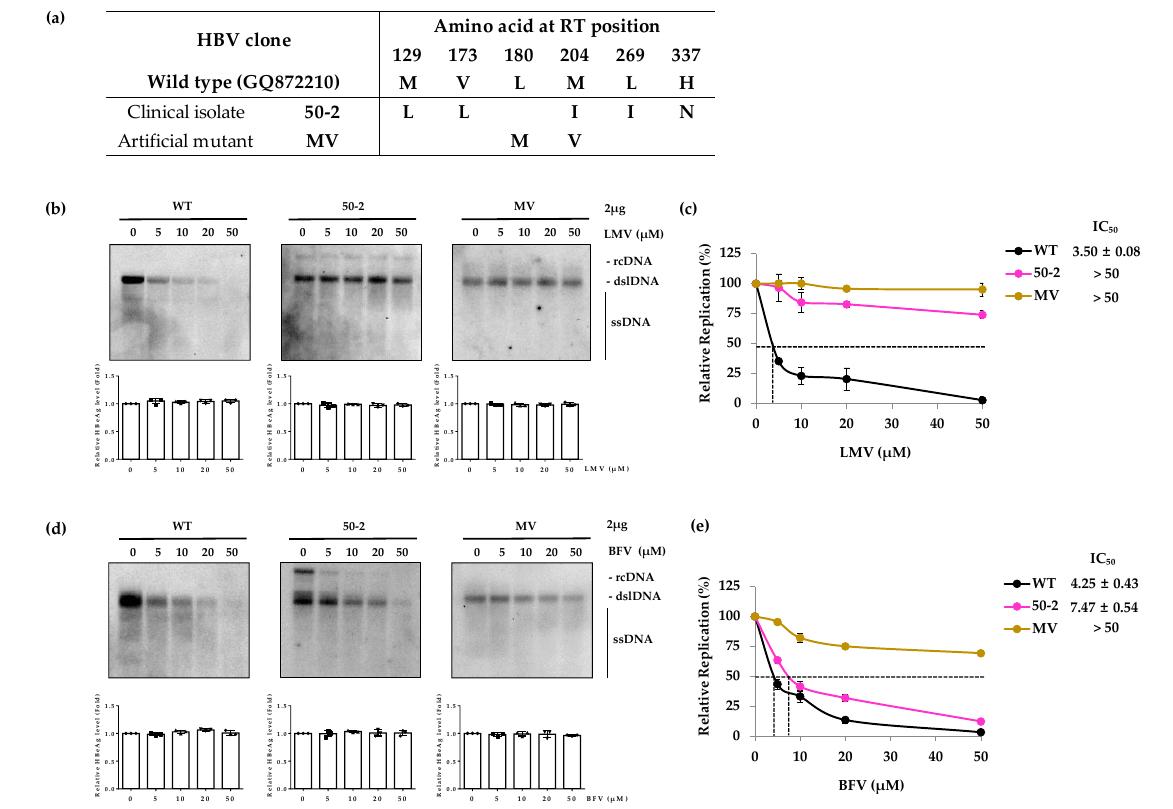
Figure 1. In vitro susceptibility of LMV-resistant HBV clones to BFV. ( a ) The sequences of LMV clones are shown. ( b , top panels) HBV 1.2mer replicons harboring LMV resistance mutations in their RT domain were transfected into the Huh7 cells. The transfected cells were treated with LMV for 4 days before harvest for the drug susceptibility assay. The replication of HBV DNA was analyzed by Southern blot. ( c ) The IC 50 values for patient-derived clone 50-2 and in vitro constructed clone MV were compared with WT. ( d ) Resistance of mutants to BFV was measure using Southern blot. ( e ) IC 50 values for BFV were determined by Southern blot and were quantified by Multigauge software. ( b , d , bottom panels) Secreted HBeAg was measured by ELISA. All data were obtained from at least three independent experiments (mean ± SD). LMV, lamivudine; BFV, besifovir; WT, wild type; HBeAg, HBV e